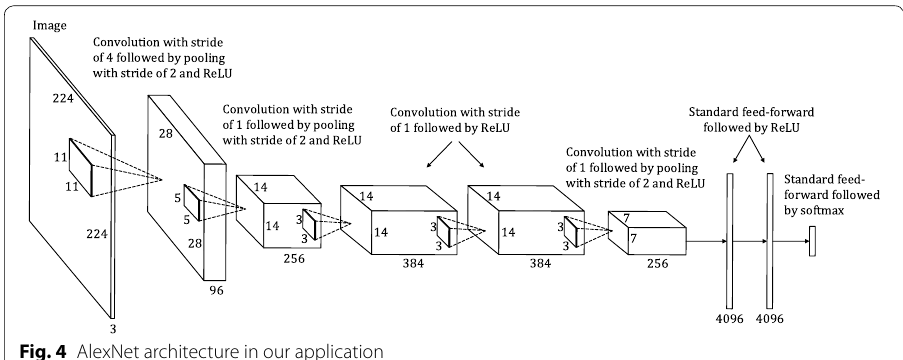
Fig. 4 AlexNet architecture in our